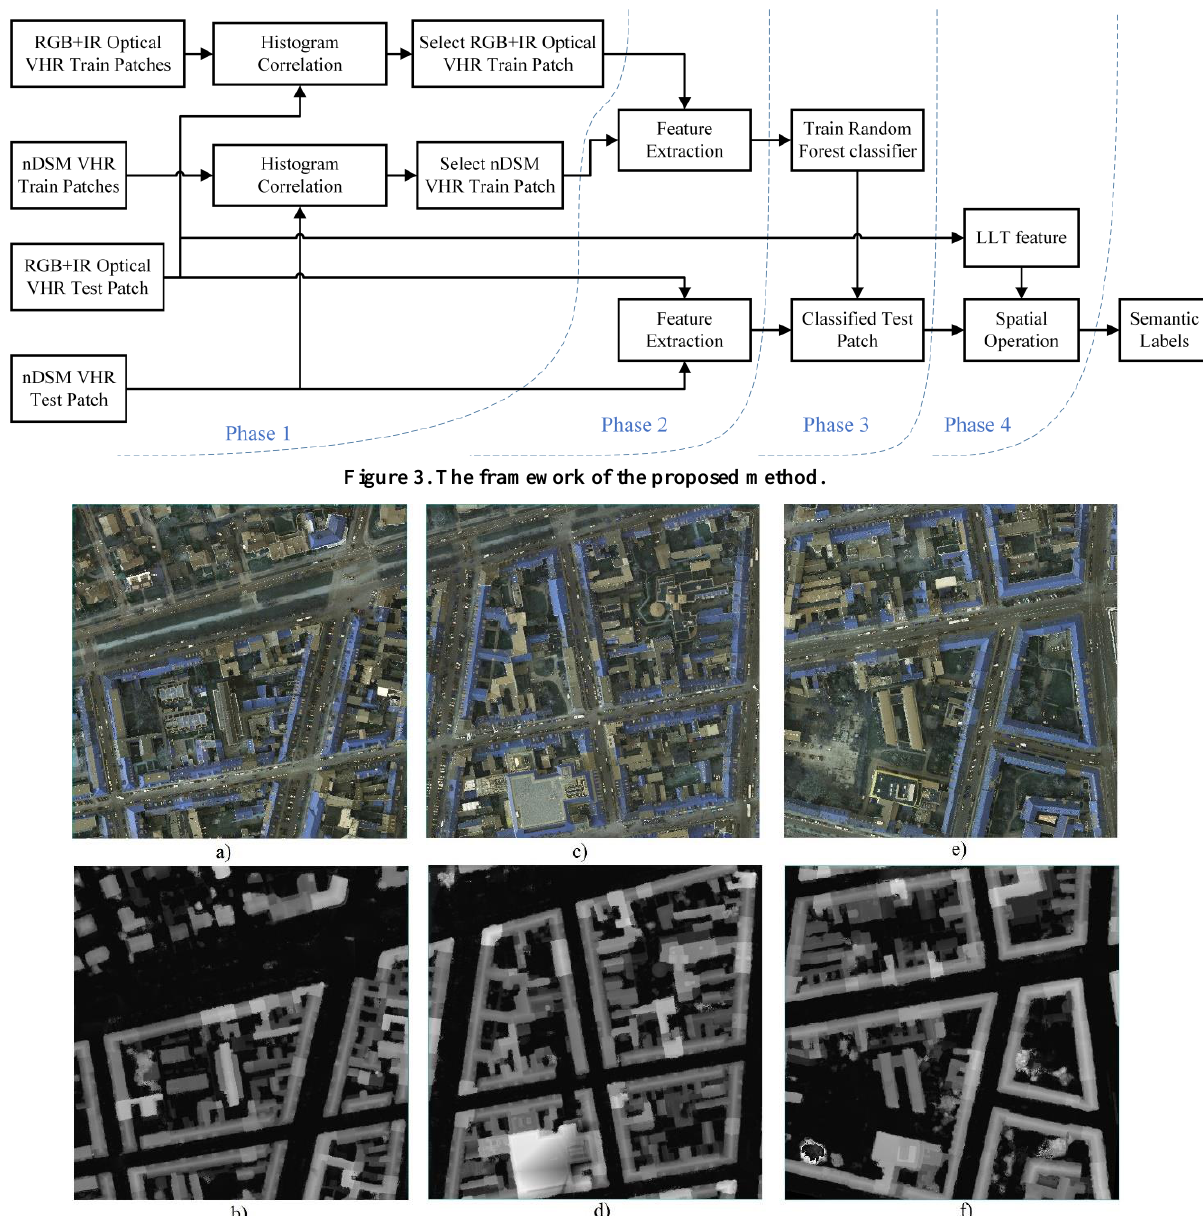
Figure 4. Similarity investigation based on histogram correlation (a) Patch 5-11 RGB (b) Patch 5-11 nDSM (c) Patch 5-12 RGB (d) Patch 5-12 nDSM (e) Patch 6-12 RGB (f) Patch 6-12